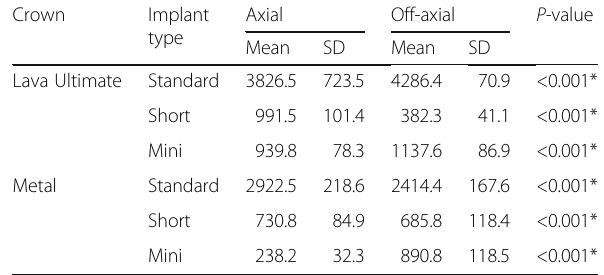
Table 5 Descriptive statistics and results of comparison between microstrains induced by the two load directions with each implant design and crown material (overall microstrains) Crown